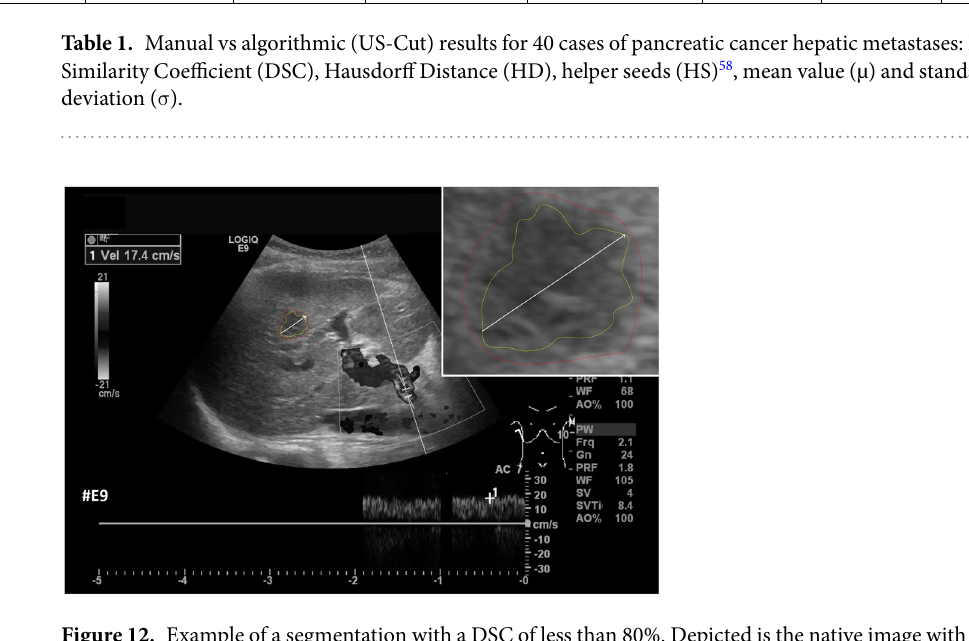
Figure 12. Example of a segmentation with a DSC of less than 80%. Depicted is the native image with a zoomed view of the metastasis (white box). The red outline represent the manual segmentation including the white arrow representing the manually drawn maximum diameter. The yellow outline represents the result of the semi-automatic segmentation.